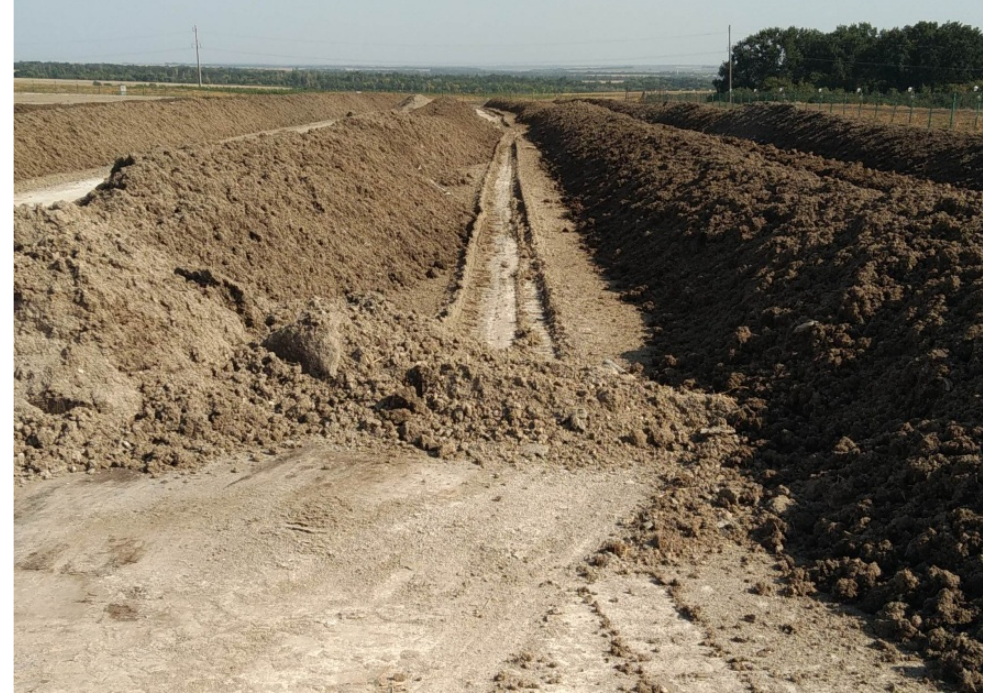
Figure 3. Heaps with compostable mixture .